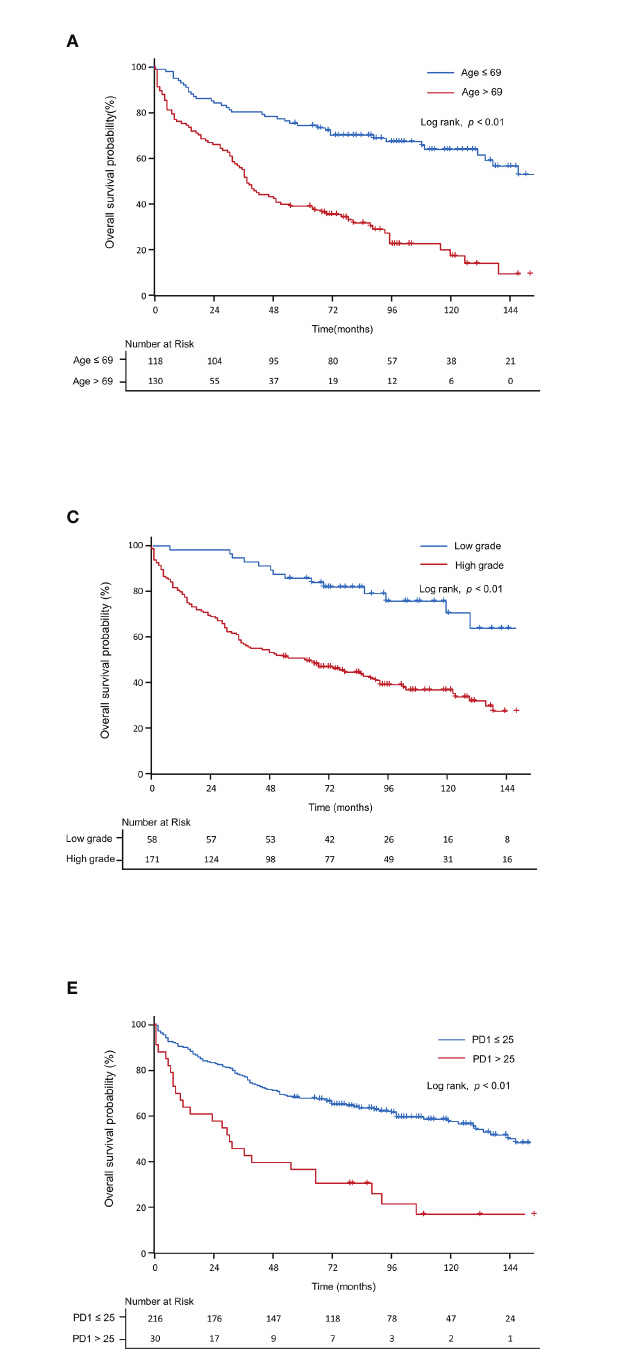
FIGURE 4 | Kaplan – Meier curve for overall survival in all patients. The Kaplan – Meier curves show overall survival according to (A) age, (B) T-stage, (C) grade, (D) EP263, (E) PD1, and (F) Ki67. PD1, programmed cell death protein